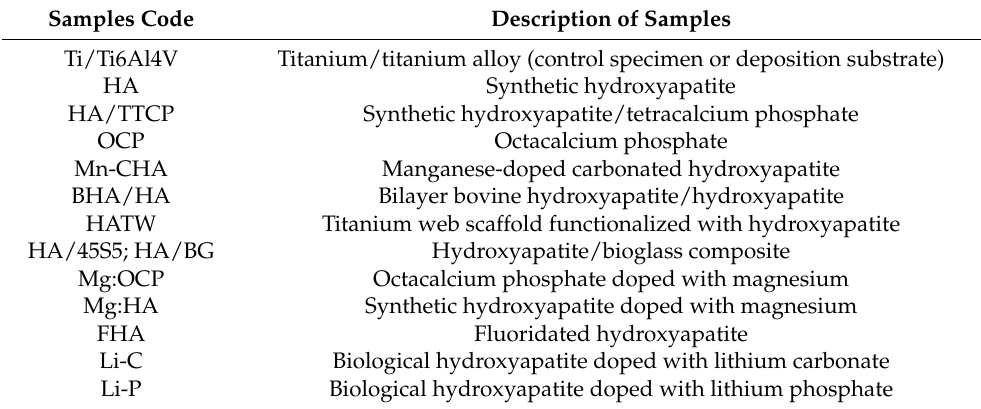
Table 2. Sample acronyms related to different materials used in the review and their explanation.